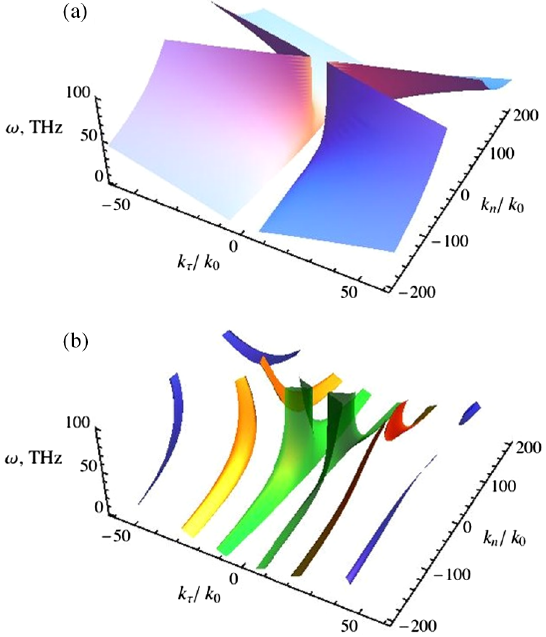
FIG. 2. The comparison of the effective medium dispersion of a photonic hypercrystal (a) to the exact solution (b) in the lossless limit. The hypercrystal unit cell is formed by 250 nm of semiconductor hyperbolic metamaterial introduced in Ref. [9] (25% n þ -doped In 0 Ga 0 As with a 5 μ m plasma wavelength . 53 . 47 and 75% Al 0 In 0 As), followed by a 250-nm dielectric layer of . 48 . 52 In 0 Al 0 . 48 . 52